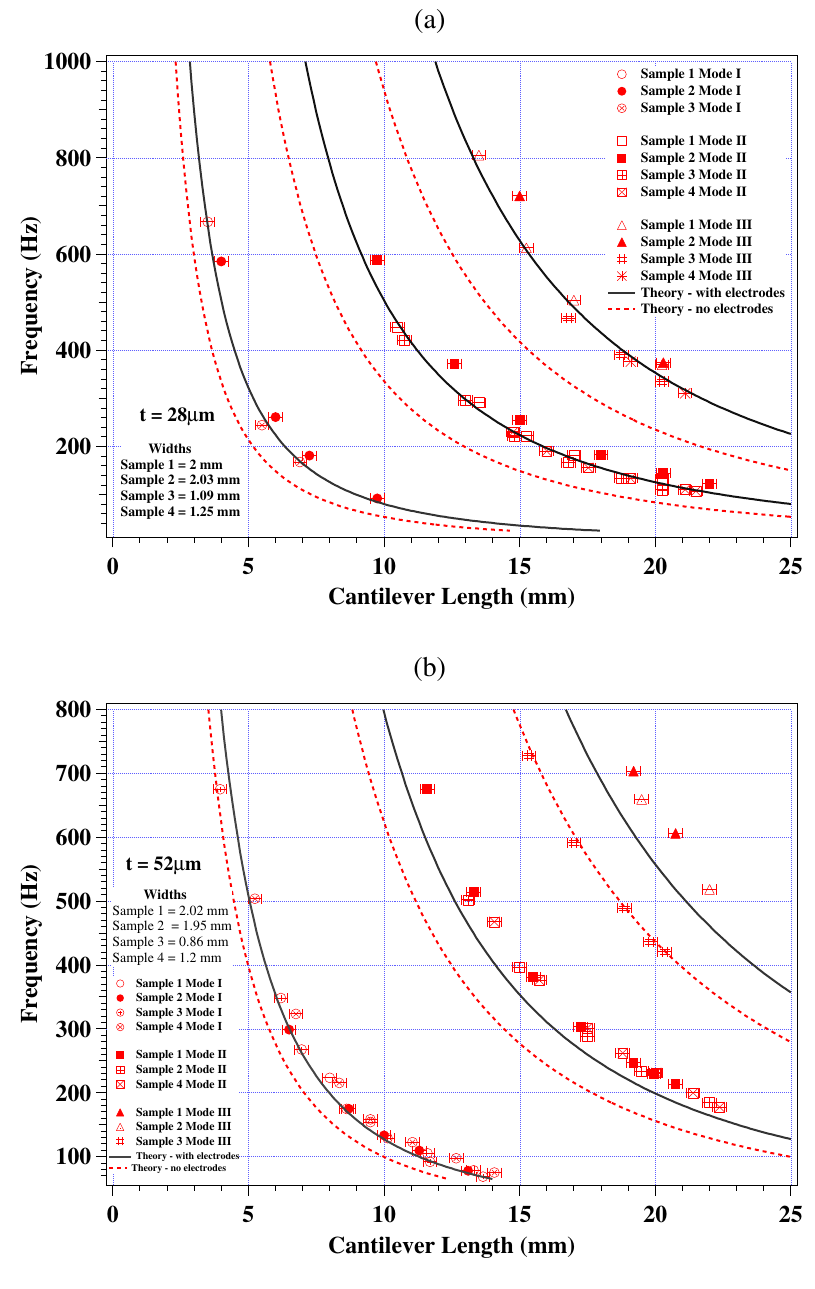
Figure 3 . The resonance frequency dependence of the first three bending vibration modes in PVF 2 cantilevers. (a) for 28 m m thick films; (b) for 52 m m thick films. Several devices of varying widths were tested as indicated. Dotted curves represent theoretical behavior not incorporating the effect of the electrodes (Equation 5). Solid curves represent theoretical behavior(Equations 6 –